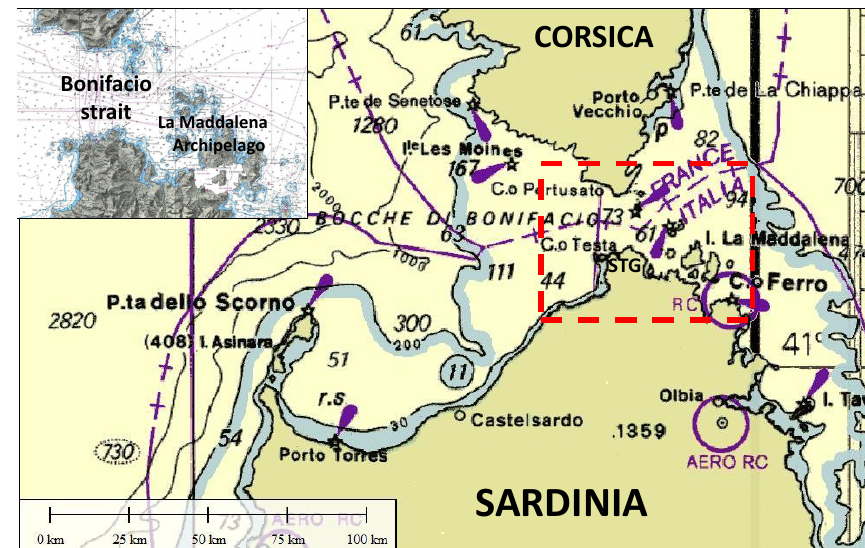
Fig. 1. Geographical